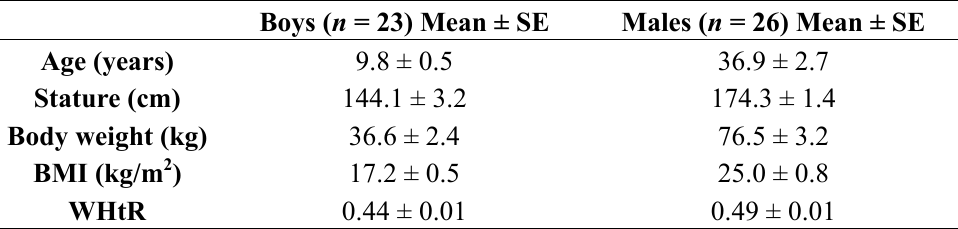
Table 1. Demographic characteristics of participants.